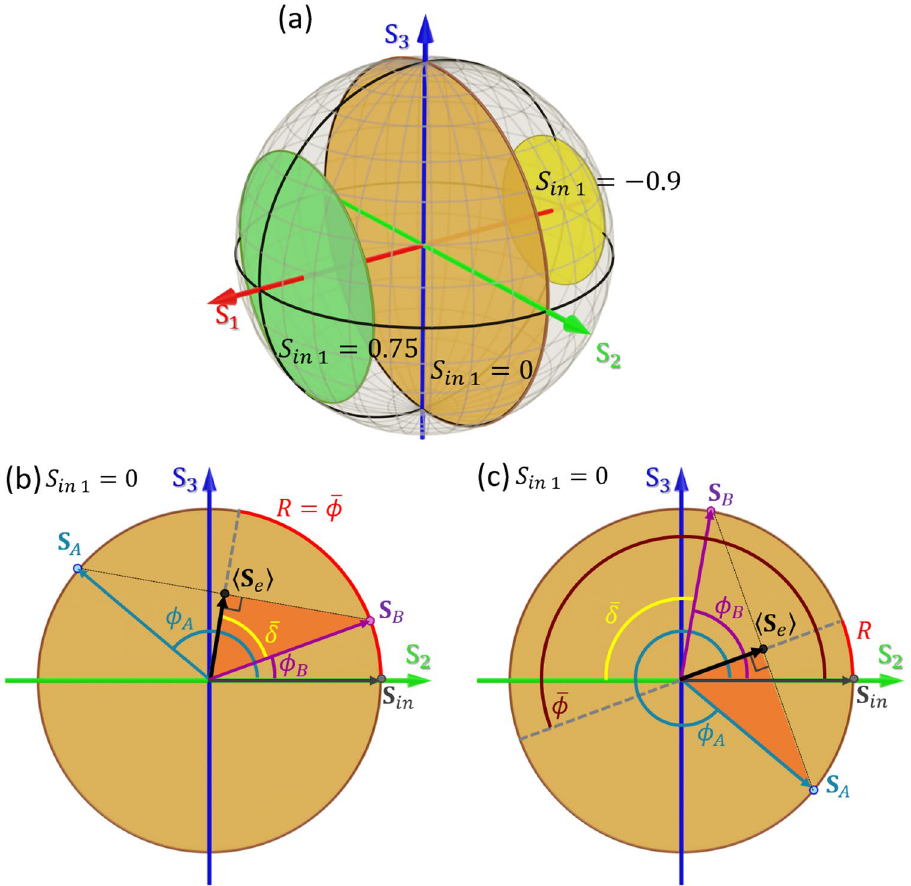
Figure 1. ( a ) Planes in the Poincaré Sphere defined by a constant value of S 1 . The plane that contains the input state S in defines all the possible SoPs that the effective state contains all the possible DoP values. ( b , c ) Composition of the effective output state addition of states S A and S B for an input state with S in 1